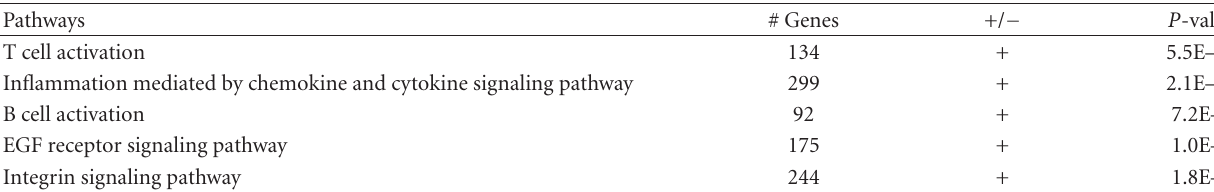
Table 2: Enriched Panther pathways in the metastases compared to the primary tumours. The five most significant pathways are shown with the number of genes in the pathways. + or − signs indicate that for the genes belonging to this pathway, the distribution of fold change values is shifted towards higher or lower values, respectively, than the overall distribution of all genes that were uploaded. P -values were calculated from the Wilcoxon Rank-Sum test and Bonferroni corrected for multiple